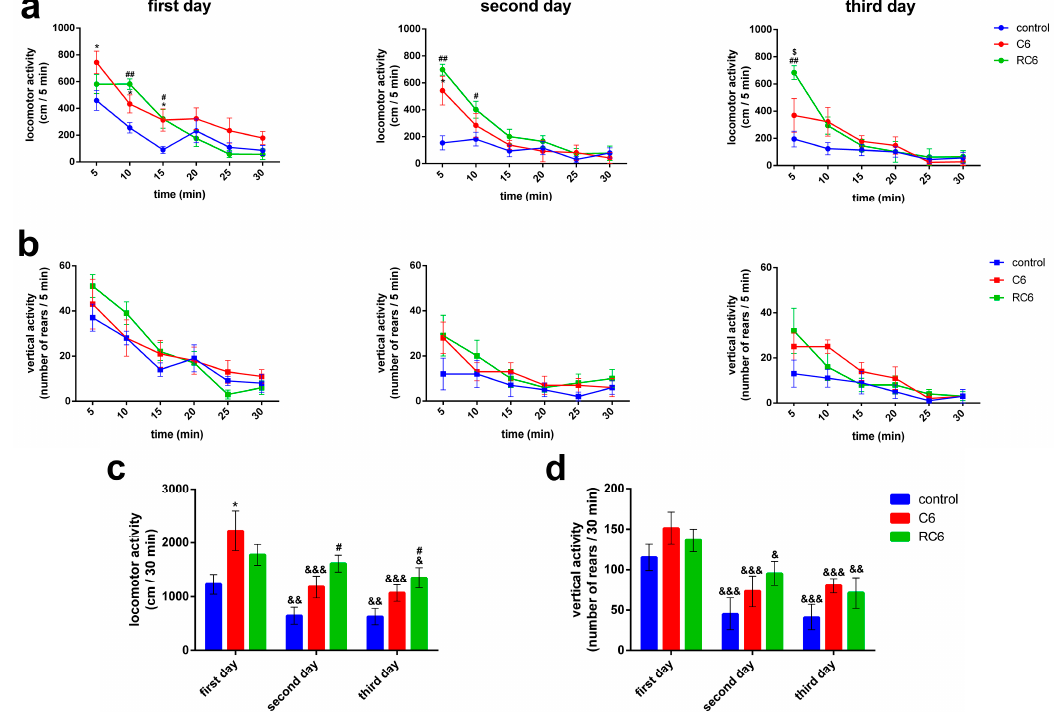
Figure 7. Motor activity and habituation of control, C6 and RC6 groups of the animals. ( a ) 5 min scores of locomotor activity; ( b ) and vertical activity of animals during 30 min period (intra-session habituation), across 3 consecutive days of registration; ( c ) Total locomotor activity; ( d ) and vertical activity of animals for the 30 min registration period during 3 consecutive days (inter-session habituation). p < 0.05 (*) C6 vs. control group; p < 0.05 (#) and p < 0.01 (##) RC6 vs. control group; p < 0.05 ($) RC6 vs. C6 group; p < 0.05 (&), p < 0.01 (&&) and p < 0.001 (&&&) second/third day vs. the first day of the same experimental